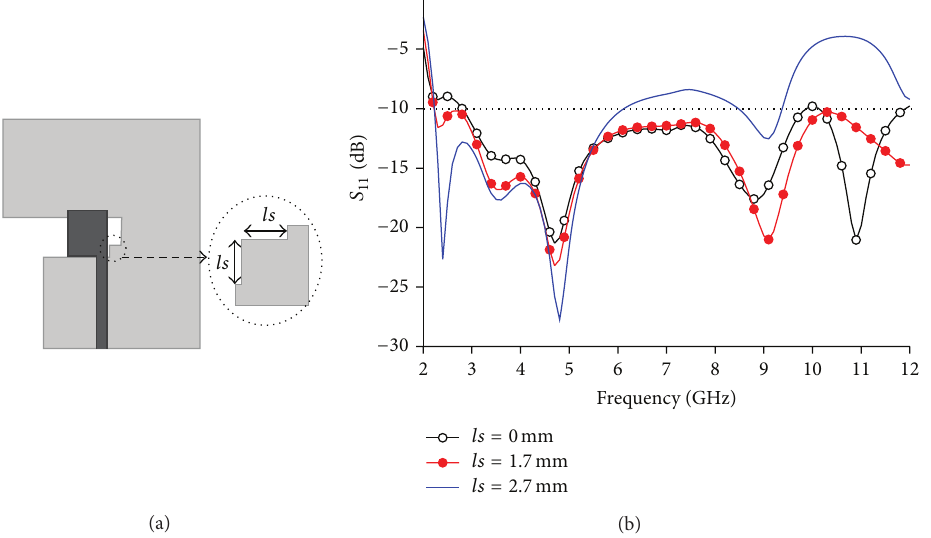
Figure 4: Magnitude of the scattering parameter S 11 versus frequency for different values of the geometrical parameter ls .